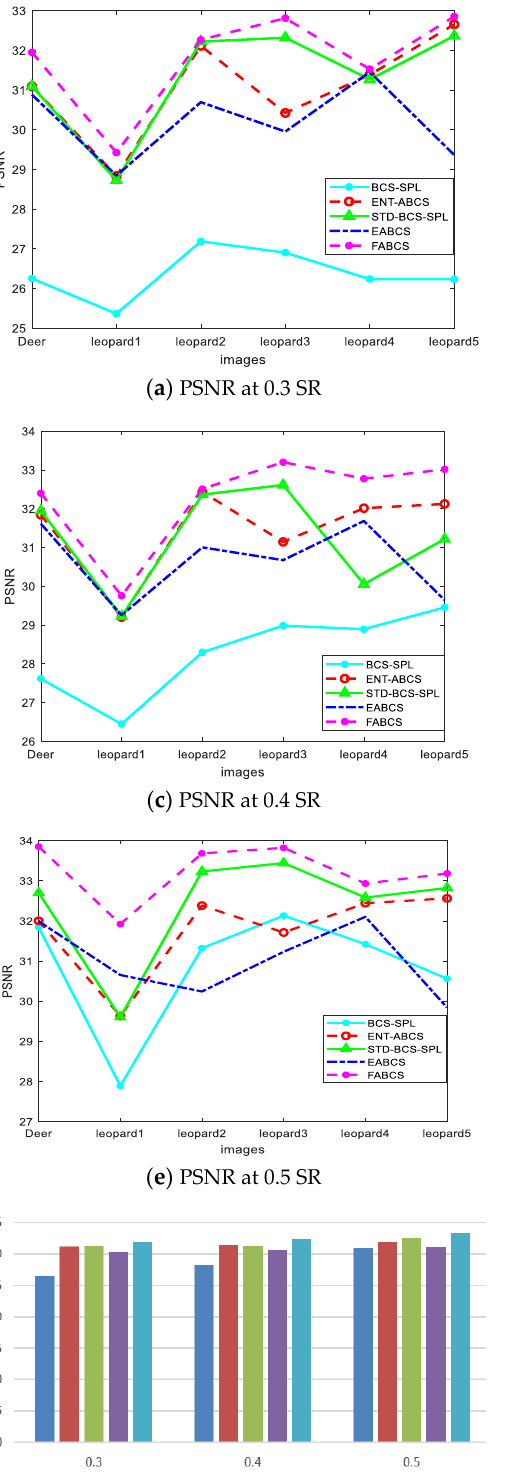
( b ) Figure 8. Performance comparison of different algorithms on Set5 Test images based on ( a ) Aver- age PSNR and ( b ) Average SSIM. Figure 9 shows the performance comparison of the fuzzy based adaptive sampling method with the non-fuzzy based adaptive sampling method. For the comparison pur- pose we have computed the sampling value of the proposed method with and without fuzzy based approach followed by BCS. The performance is evaluated for standard da- taset images and the average value is considered. Average PSNR and SSIM value of the fuzzy based ABCS method is 2% higher than the non-fuzzy based ABCS method. The performance of the fuzzy method is higher due to better and a balanced distribution of the sampling rate allocation for the blocks.